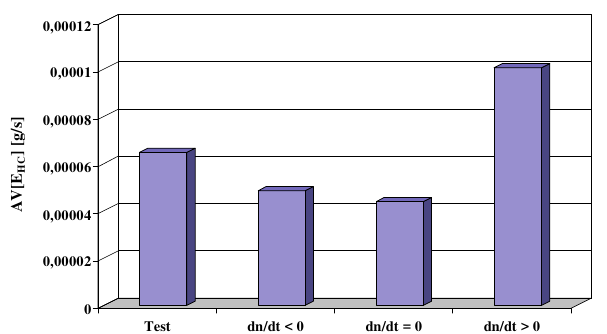
Fig. 27. Comparison of the mean carbon monoxide emission value in the test and in the states corresponding to the negative, zero and positive values of the engine speed derivative with respect to time – for the NEDC and Malta